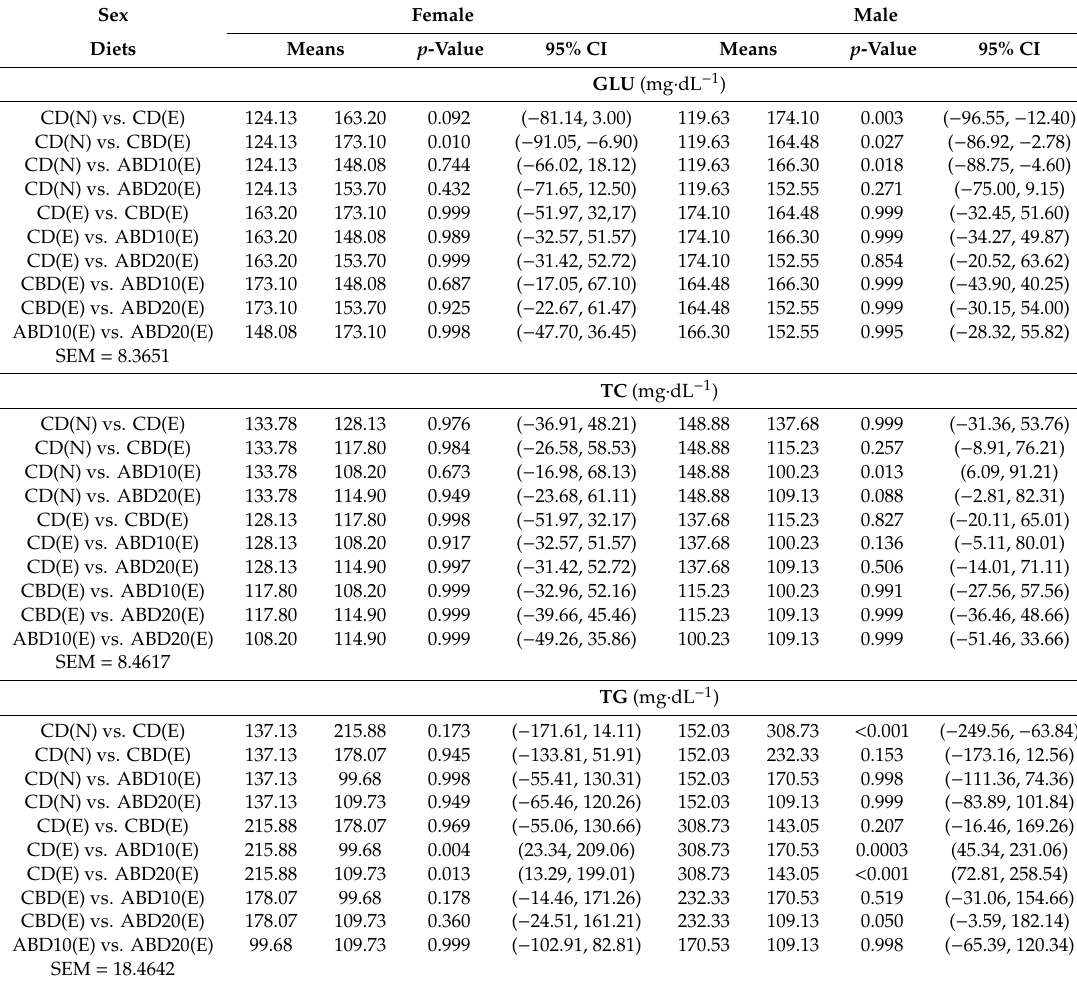
Table 4. E ff ect of 8-week consumption of diets prepared with bread of amaranth on serum glucose (GLU), total cholesterol (TC) and triglycerides (TG) in rats (weeks 23 to 31 of